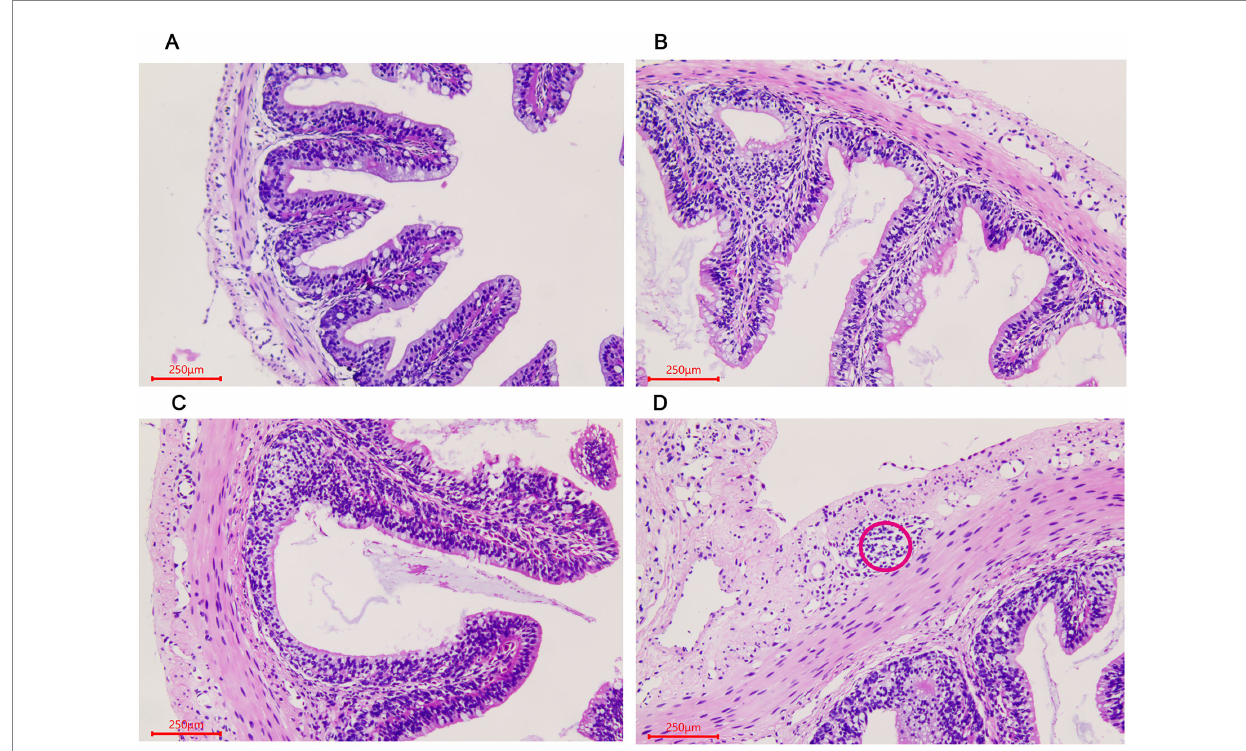
FIGURE 1 Morphological changes of the small intestine in Andrias davidianus. (A) The small intestine in ADY. (B) The small intestine in ADE. (C) The small intestine in ADS. (D) Lymphoid follicular cluster of the small intestine in ADS (as shown in red circle). The sections were observed using high power fields of 500-fold magnification with several measurements at different positions in each